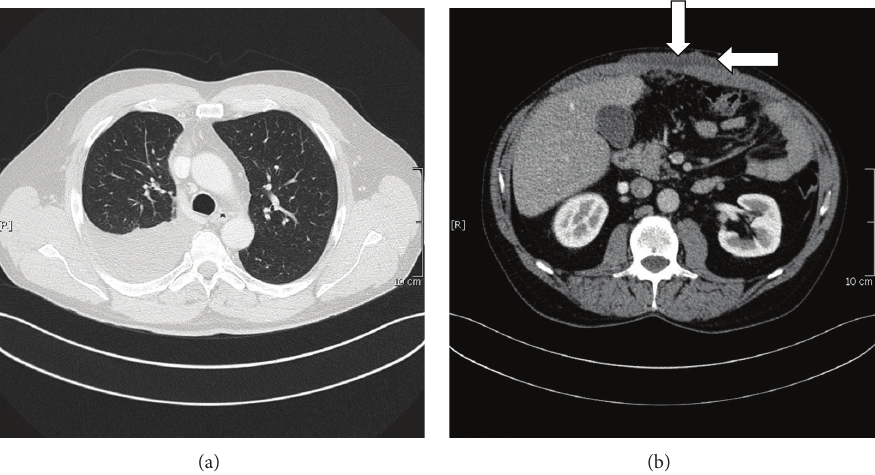
Figure 1: (a) CT scan shows a pleural effusion; the surface of the right lung is colonized and infiltrated by pleural mesothelioma. (b) Large tumor mass of the abdominal wall (10 × 7cm) without penetration into the peritoneum.